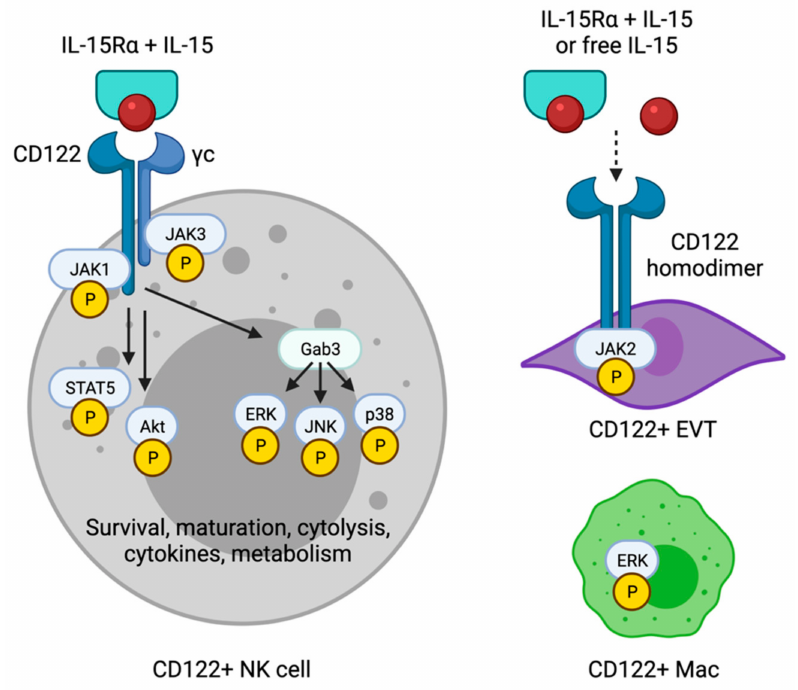
Figure 1. Components of IL-15 receptors and signaling cascades in IL-15-responsive cell types at the maternal–fetal interface. NK cells express CD122 and the common gamma chain ( γ c) and activate JAK-STAT, Akt, and MAP kinases in response to IL-15 presented in the context of IL-15R α . IL-15 drives numerous functions in killer lymphocytes, including classical and uterine NK cells. Emerging IL-15-responsive cell types, such as CD122+ macrophages (CD122+ Mac) and CD122+ extravillous trophoblasts (EVT), may express alternative forms of the IL-15 receptor and activate non-classical signaling cascades downstream of IL-15. Created with Biorender.com, accessed 3 October